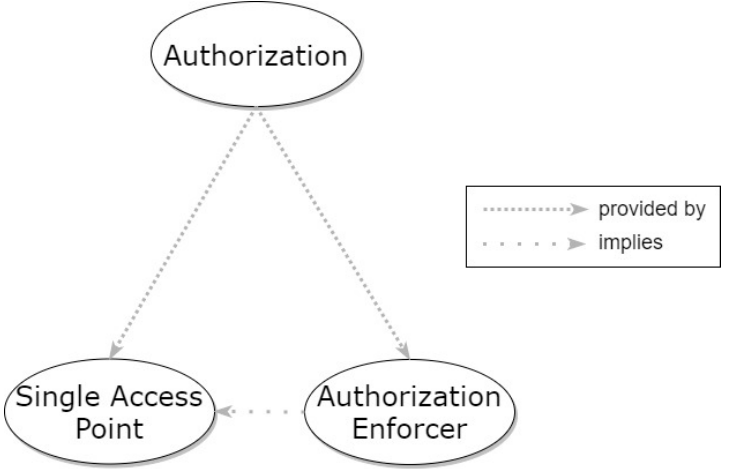
Figure 12. Hierarchical graph of Authorization property and relevant patterns.